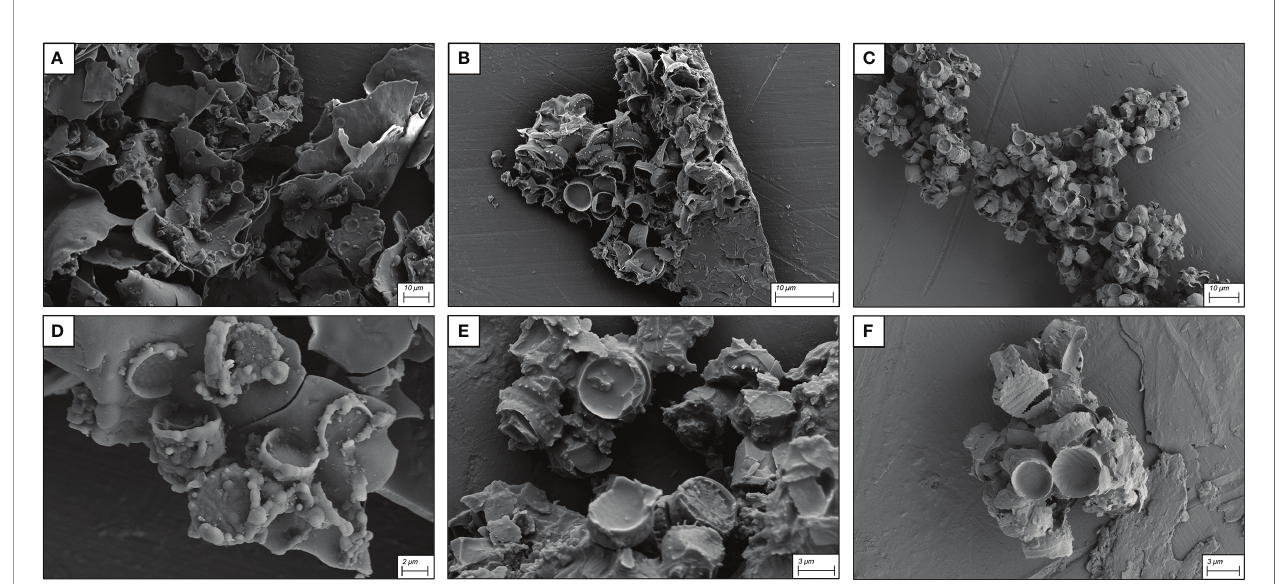
FIGURE 2 | SEM micrographs of frustules functionalized with the three solvents: (A) : milli-Q water, (B) : toluene and (C) : hexane. (D – F) show details at high magni fi cation of the same solvent conditions as (A – C)